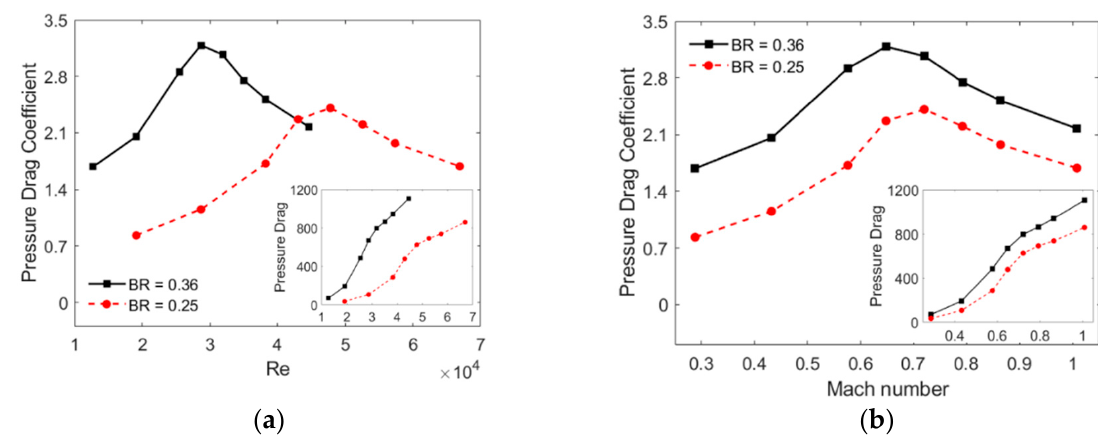
Figure A3. Variation of pressure drag coefficients on blockage ratio and (a) Re, (b) Mach number. Insets represent the variation of drag.